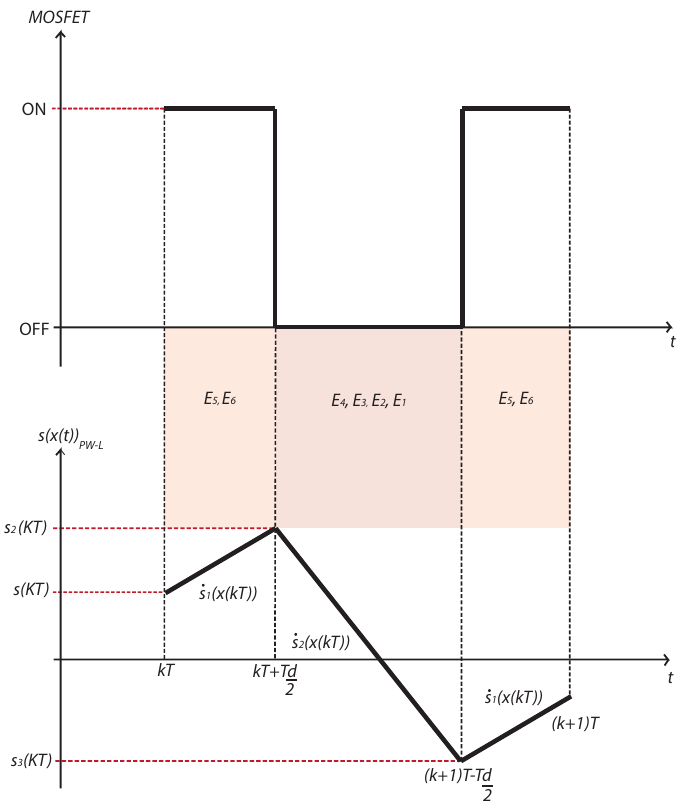
Figure 2. Schematic diagram of the approximated Zero Average Dynamics (ZAD) function. Upper panel shows the two positions of the MOSFET (ON and OFF) with the the corresponding piece-wise linear approximation of the function s ( x ( t )) PW − L . When the MOSFET position is ON, topologies E 5 and E 6 are physically feasible. Similarly, with MOSFET position OFF, only E 1 , E 2 , E 3 and E 4 are the admissible